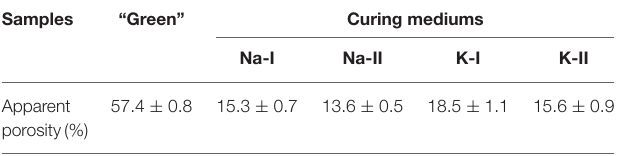
TABLE 3 | The apparent porosities of the green and 7-day heat-cured samples. Samples